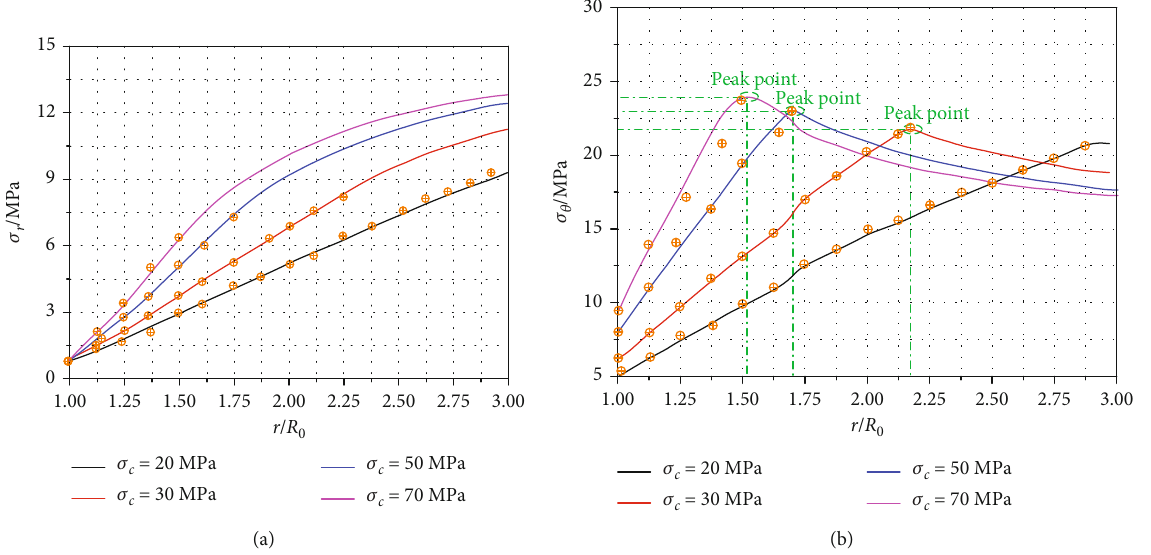
Figure 11: Curves of stresses under di ff erent uniaxial compressive strengths. Table 1: Comparison for plastic zone radii of surrounding rock under di ff erent uniaxial compressive